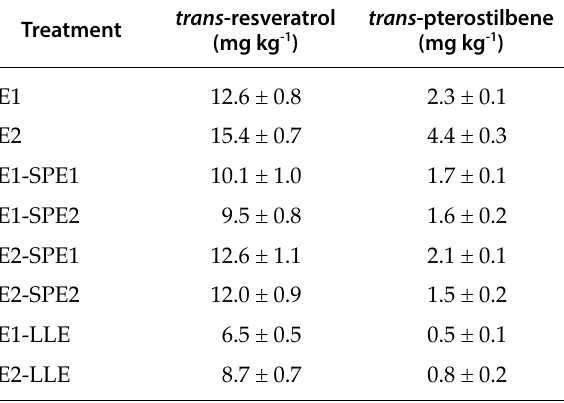
Table 1. Trans -resveratrol and trans -pterostilbene concen- trations (fresh weight values) in samples of tiger-striped grapevine leaves obtained with different extraction/puri - fication techniques. The values shown in the Table are the averages of three